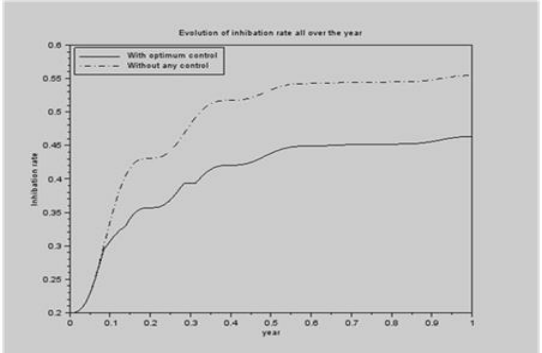
Fig2 : Evolution of inhibition rate over a one-year period with θ 0 = 0 . 2 , θ 1 = 1 − 0 . 4 .